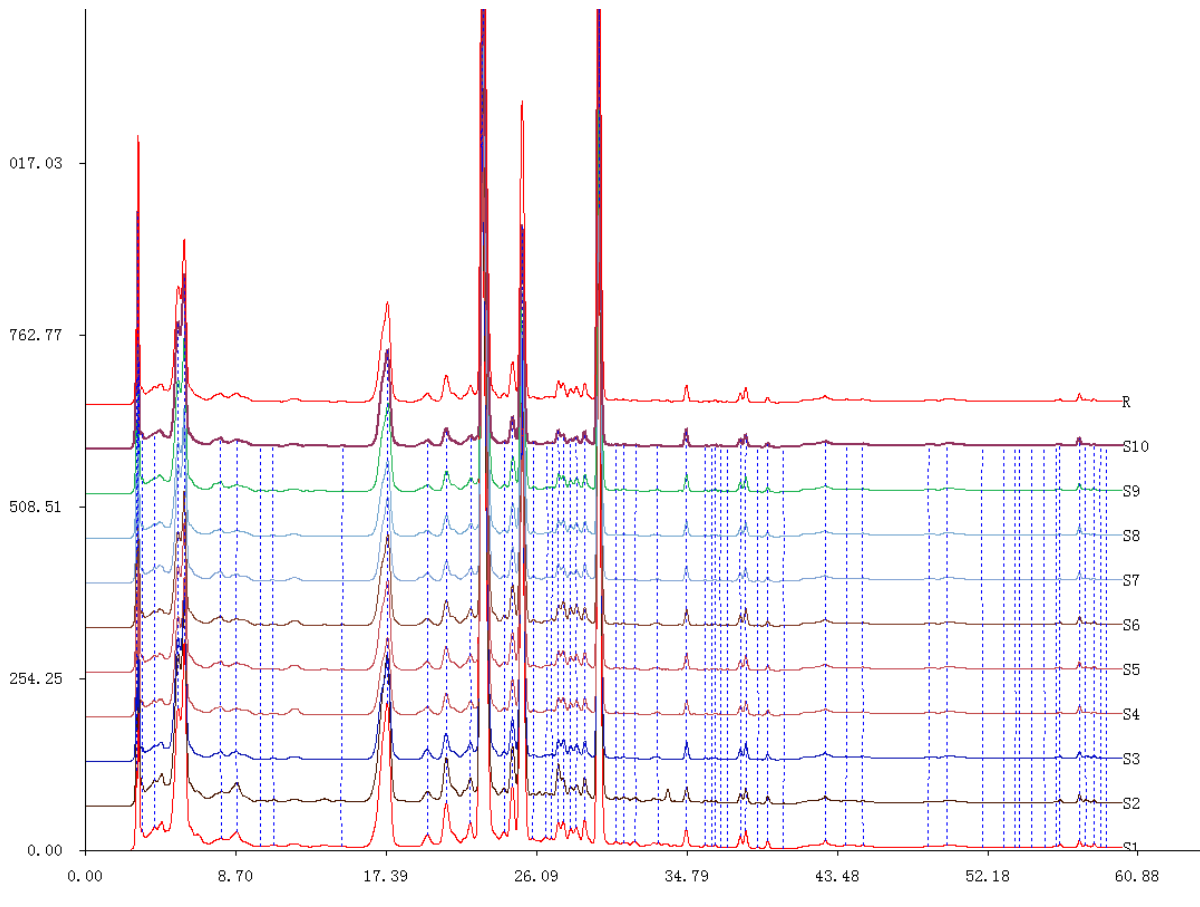
Figure 5: Similarity evaluation chromatogram of M. halliana